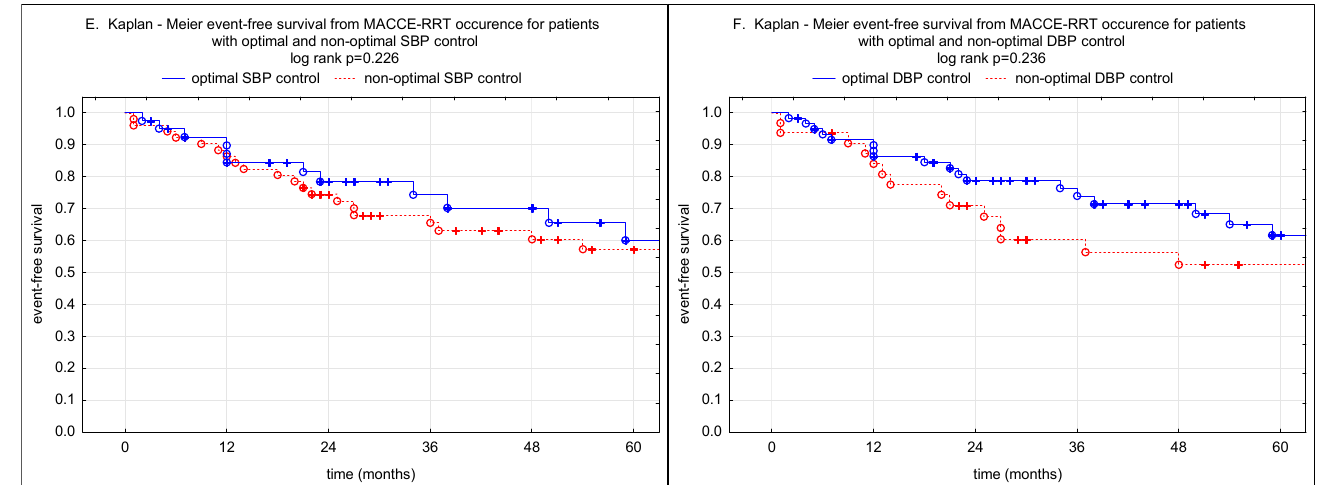
Figure 2. The Kaplan ‐ Meier plot depicts survival after renal artery stenting for parameters associated with outcome. ( A ) patients with maintained glycemic target goals (continuous blue line) and patients with non ‐ optimal diabetic control (discontinuous red line). ( B ) patients with previous stroke (discontinuous red line) and non ‐ stroke (continuous blue line). ( C ) patients with baseline eGFR ≥ 45 mL/min/m 2 (continuous blue line) and the eGFR < 45 mL/min/m 2 (discontinuous red line). ( D ) patients with final, post intervention, eGFR ≥ 45 mL/min/m 2 (continuous blue line) and the eGFR < 45 mL/min/m 2 (discontinuous red line). ( E ) patients with optimal target goals of SBP after PTA (continuous blue line) and patients with non ‐ optimal SBP control (discontinuous red line). ( F ) patients with optimal target goals of DBP after PTA (continuous blue line) and patients with non ‐ optimal DBP control (red discontinuous line). Ticks along the lines represent censored cases. The log ‐ rank test p ‐ value between the two groups is presented in each figure.